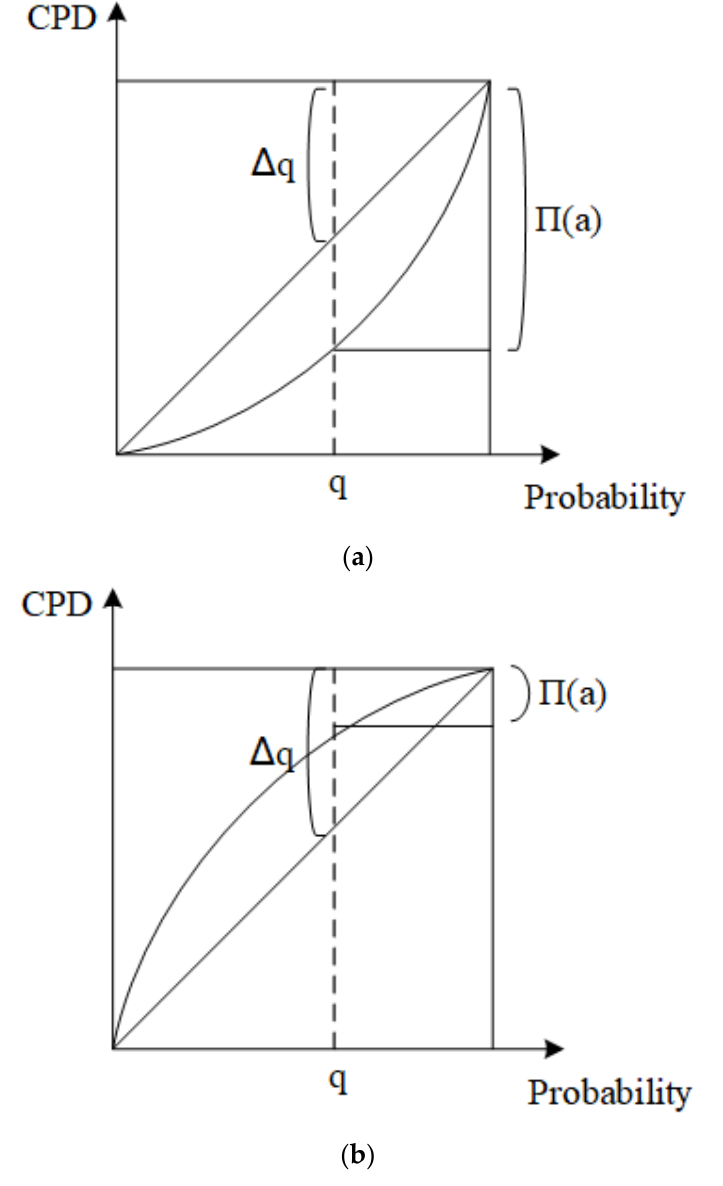
Figure 1. Utility function diagram. ( a ) the utility function diagram of the decision maker under pessimism; ( b ) the utility function diagram of the decision maker under optimism.